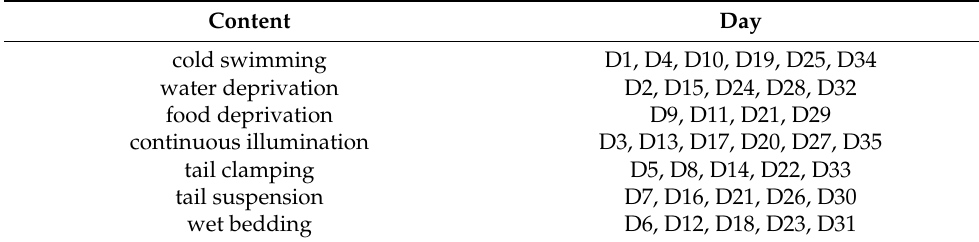
Table 1. Daily schedule of the CUMS